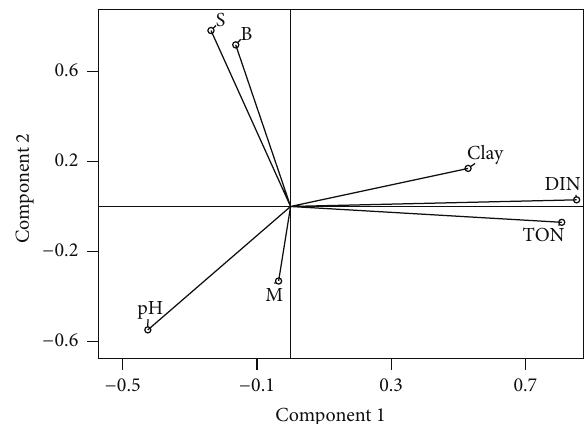
Figure 8: The principal component analysis for soil properties, S- salt, B-bulk density, M-moisture content, clay (the content of grain with diameter < 0.063 𝜇 m), DIN-inorganic nitrogen, ammonia and nitrates, and TON-organic